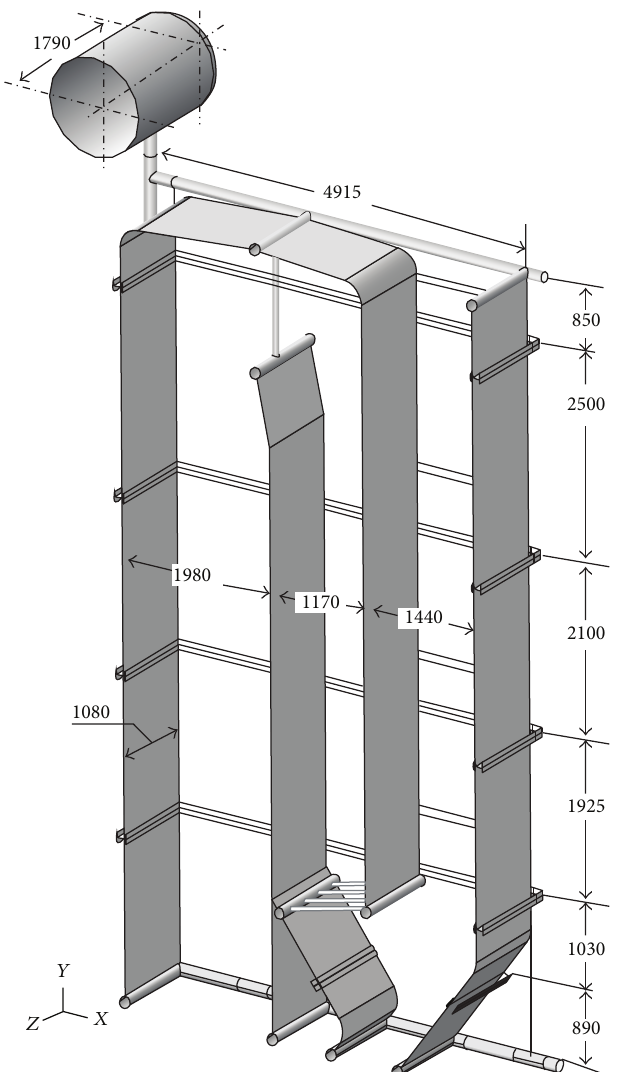
Figure 5: Calculation geometry model approximated as the equivalent orthotropic plate (dimensions are in